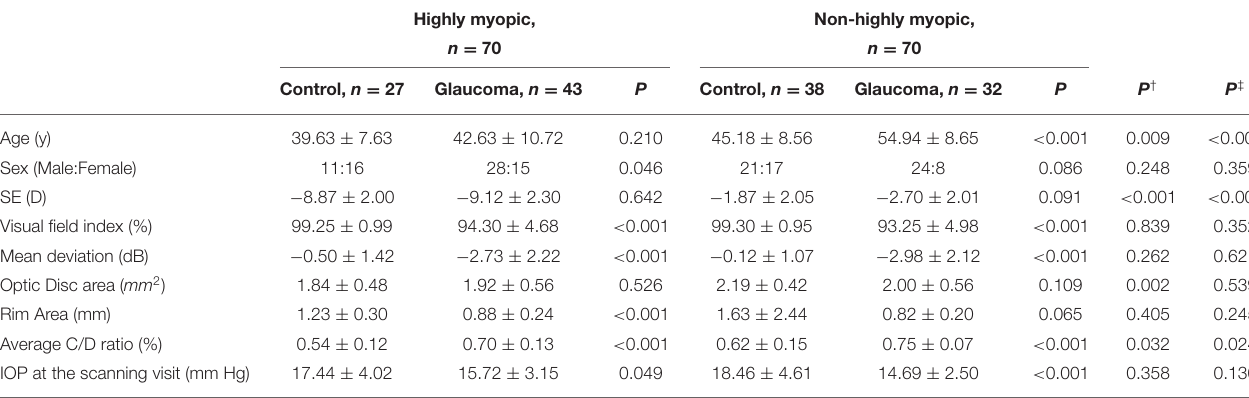
TABLE 1 | Baseline characteristics of the control and glaucoma